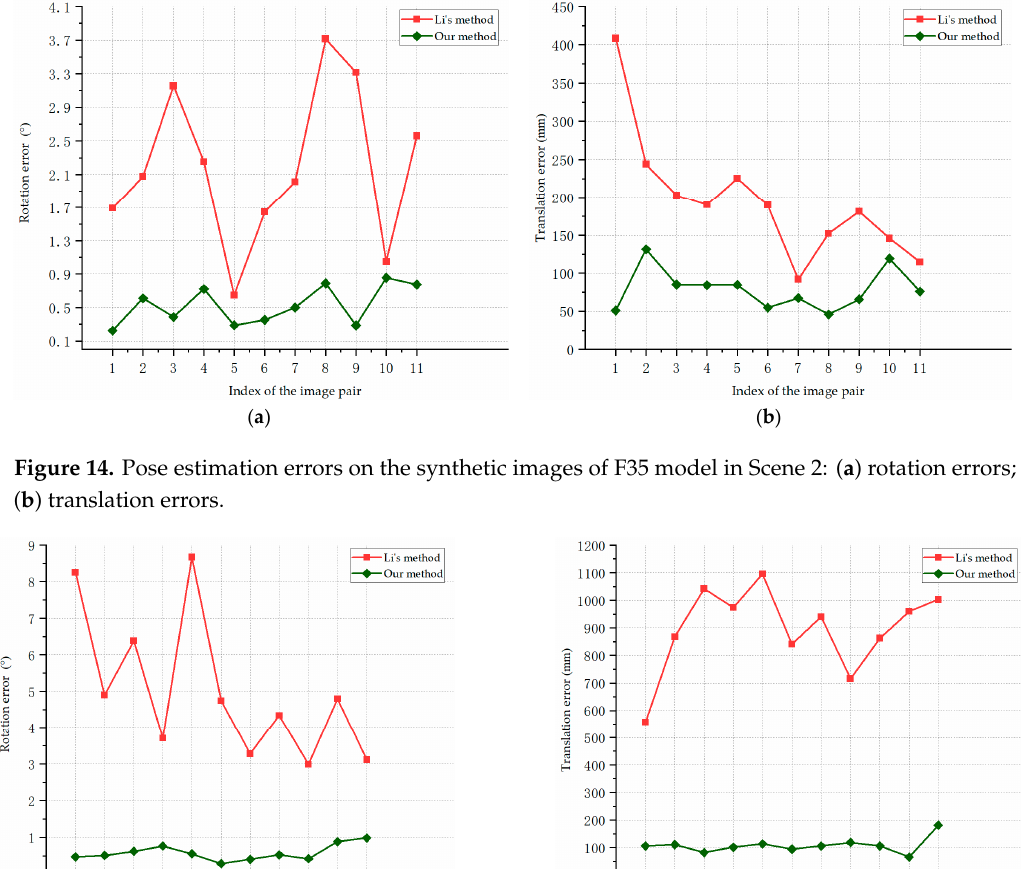
Figure 13. Pose estimation errors for the synthetic images of F35 model in Scene 1: ( a ) rotation errors; ( b ) translation errors.